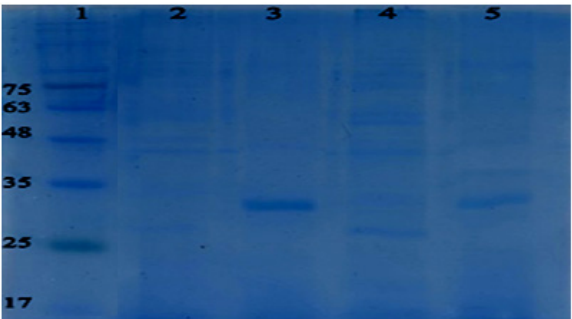
Figure 4 . SDS-PAGE Analysis of the Extracellular DFPase. Lane 1: Protein marker Cinnagen PR911654, Lane 2: The extracellular proteins of native B. subtilis WB600 after 72 h. Lane 3: The extracellular proteins of B. subtilis pW600/ dfpase after 72 h, which shows the band about 35 kDa related to secretory DFPase. Lane 4: The extracellular proteins of native B. subtilis WB600 after 48 hours. Lane 5: The extracellular proteins of B. subtilis pW600/ dfpase after 48 hours, which shows the band about 35 kDa related to secretory DFPase.